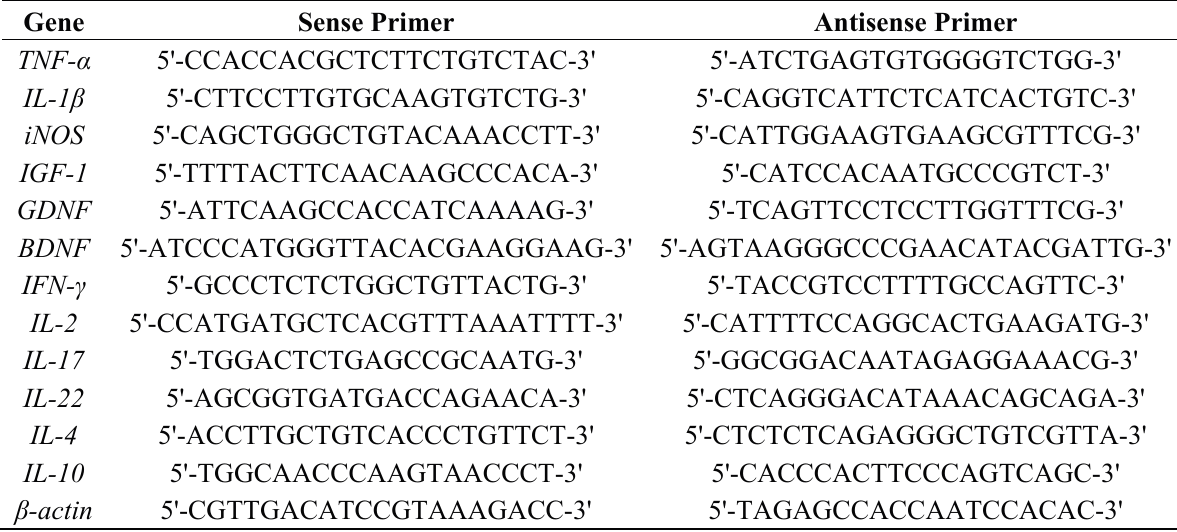
Table 1. Sequences of PCR